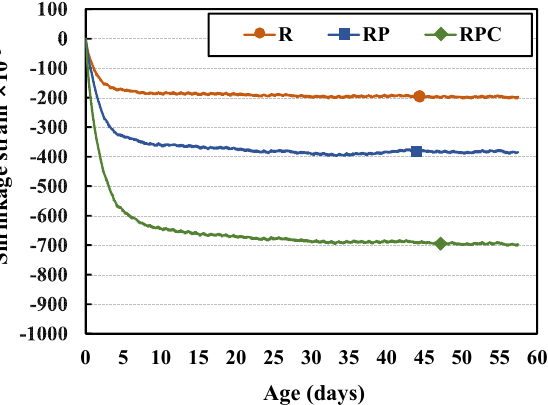
Figure 8. Shrinkage deformations occurring in specimens of different ages.